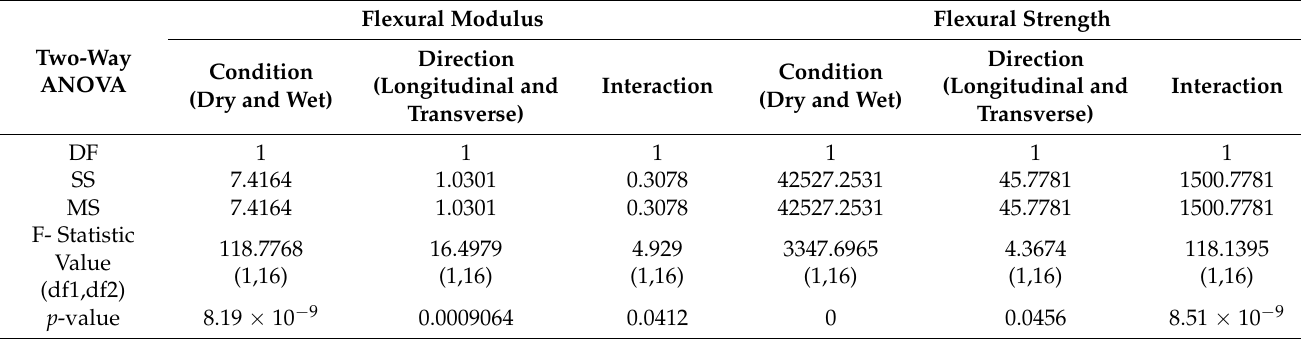
Table 7. Two-way ANOVA results on the flexural properties of Deccani sheep horns.